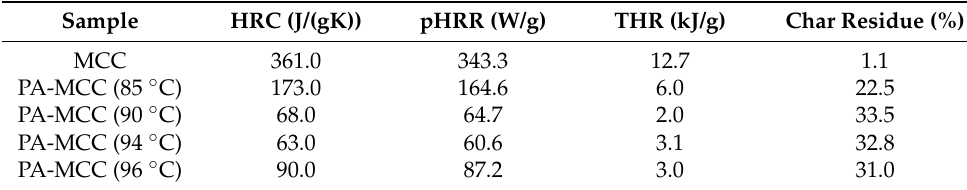
Table 3. PCFC data of PA-MCC obtained at different reaction